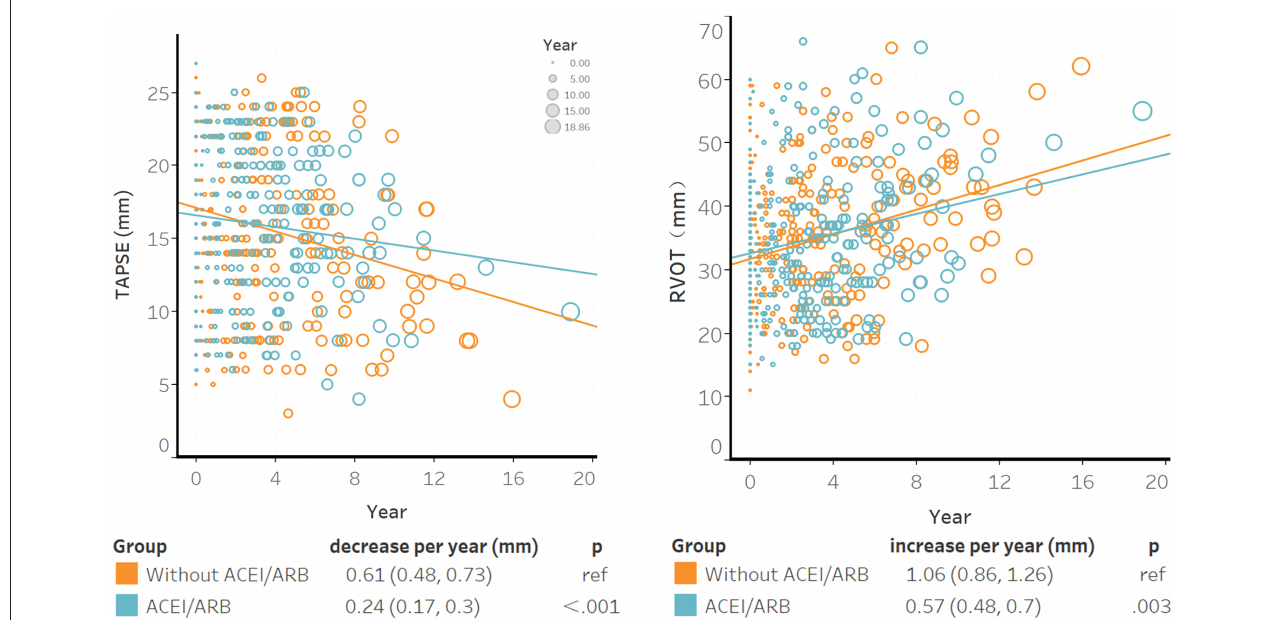
FIGURE 1 | The association between ACEI/ARB treatment and right ventricular progression based on results of the transthoracic echocardiogram. Individual points were the unadjusted time to baseline TAPSE or RVOT during follow-up; larger circles represented longer time intervals from baseline. The blue trendline represents the progression speed in the ACEI/ARB group, and the orange trendline represents the progression in the non-ACEI/ARB group. Both trendlines were calculated using linear mixed models. ACEI, angiotensin-converting enzyme inhibitors; ARB, angiotensin receptor blockers; RVOT, right ventricular outflow tract; TAPSE, tricuspid annular plane systolic